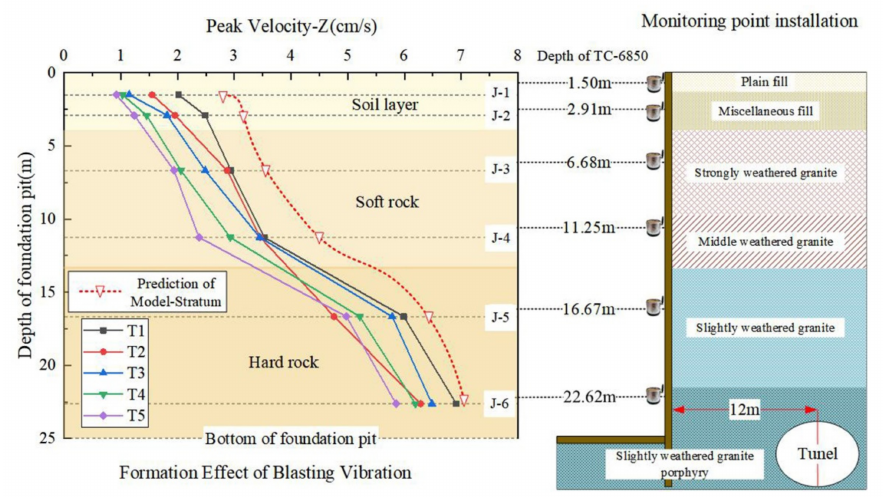
Figure 9. Variation of blasting vibration on the surrounding rock of the foundation pit.